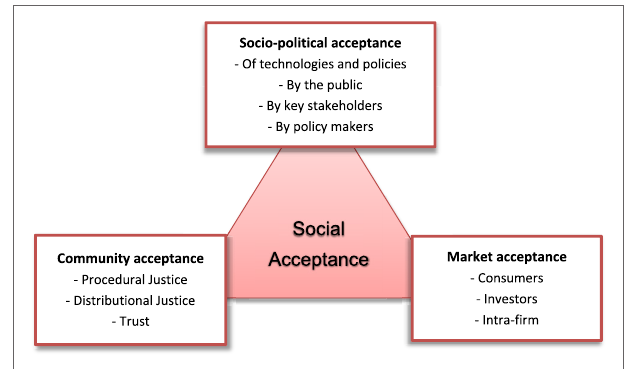
FigURe 2 | The “Triangle of Social Acceptance.” The “triangle” framework proposes that the social acceptance of policy and technology innovation is determined by the opinions and actions of stakeholders operating on three dimensions (i.e., socio-political, market, and community acceptance). The figure is adapted from Wüstenhagen et al. (2007) and is reproduced with the permission of the copyright